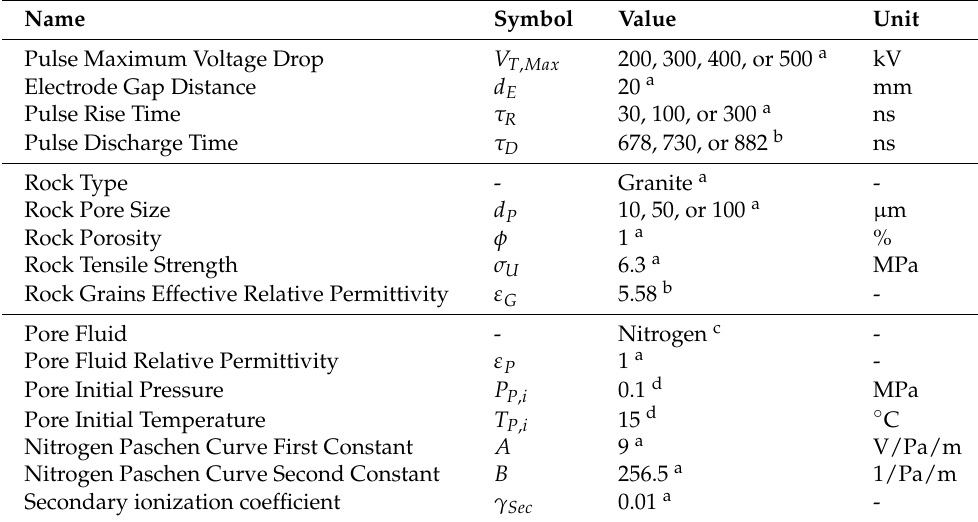
Table 1. Model parameters. The groups (separated by a horizontal line) represent the parameters of the pulse, the rock, and the pore